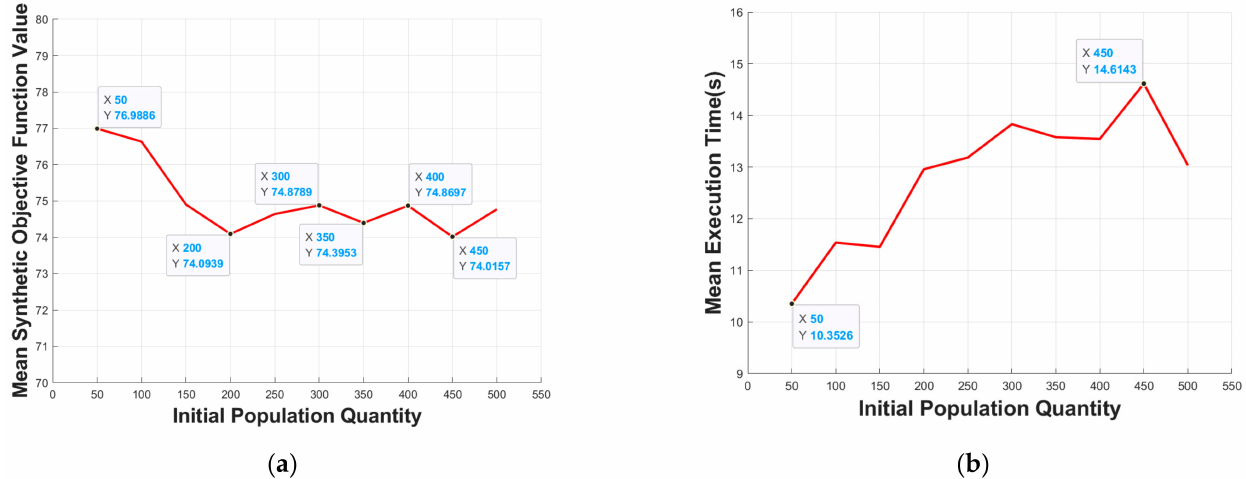
Figure 15. Effect of the initial population quantity on: ( a ) mean synthetic objective function value; ( b ) mean execution